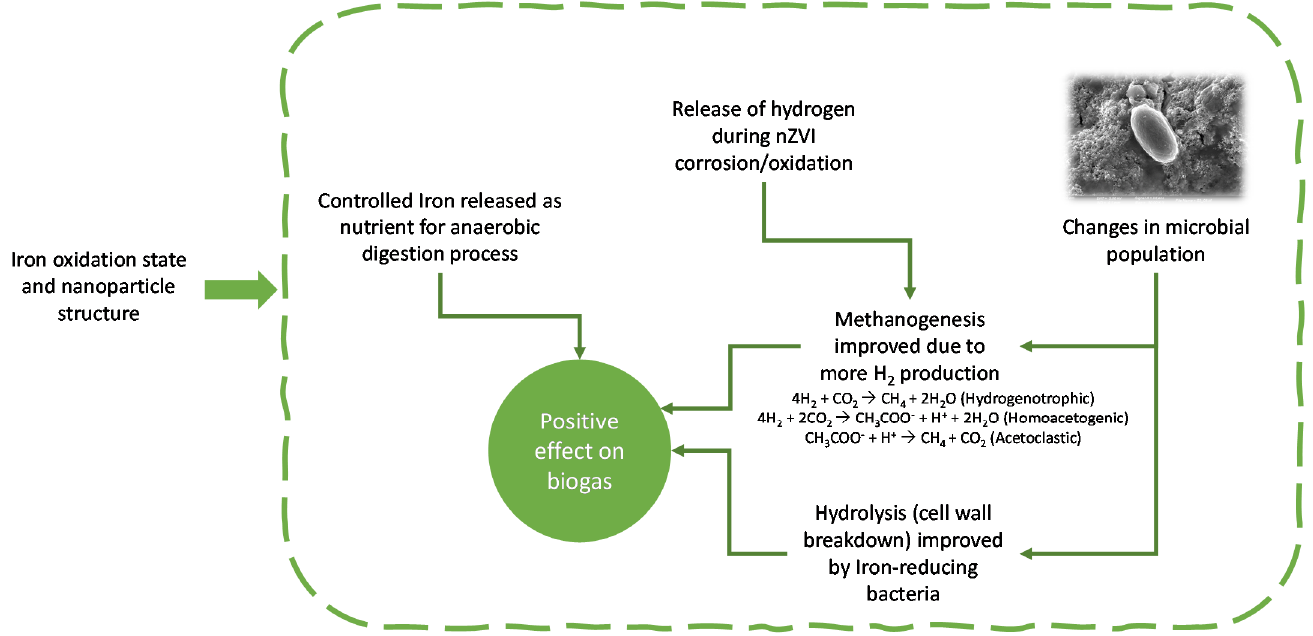
Figure 2. Scheme of the mechanisms proposed by the enhancement of anaerobic digestion using Figure 2. nanomaterials.